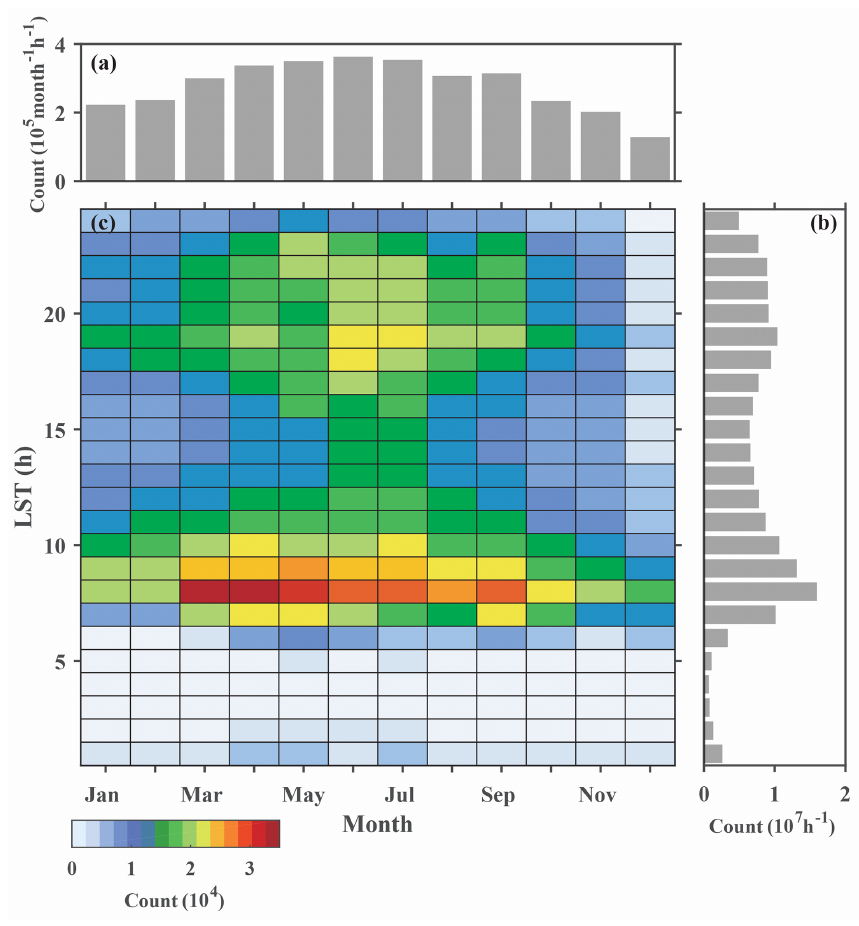
Figure 5. (a) Seasonal variation in global hourly counts of smartphone data for each month. (b) Diurnal variation in global smartphone data counts. (c) Annual mean hourly data count at different local standard times (LSTs) and